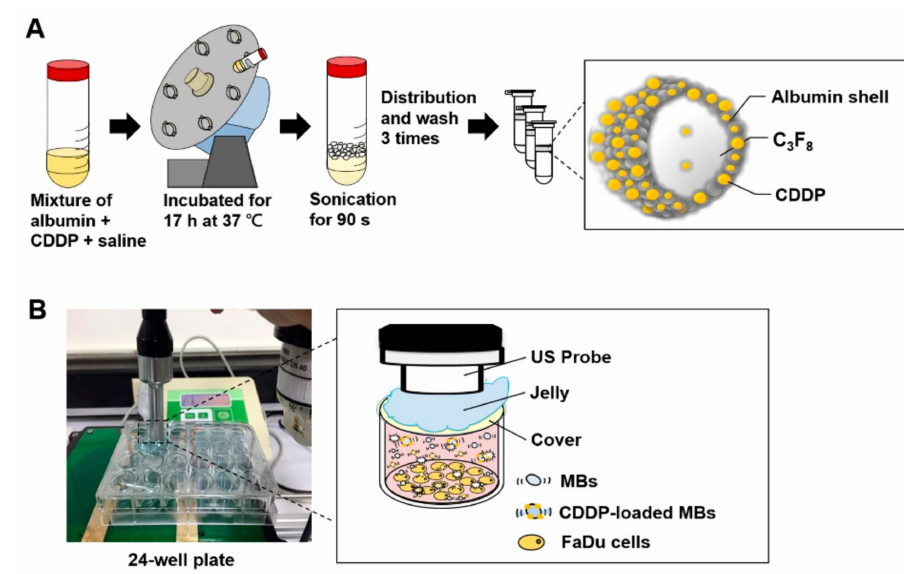
Figure 8. Schematic illustration of ( A ) the preparation of CDDP-loaded MBs and ( B ) optimization of ultrasound parameters in